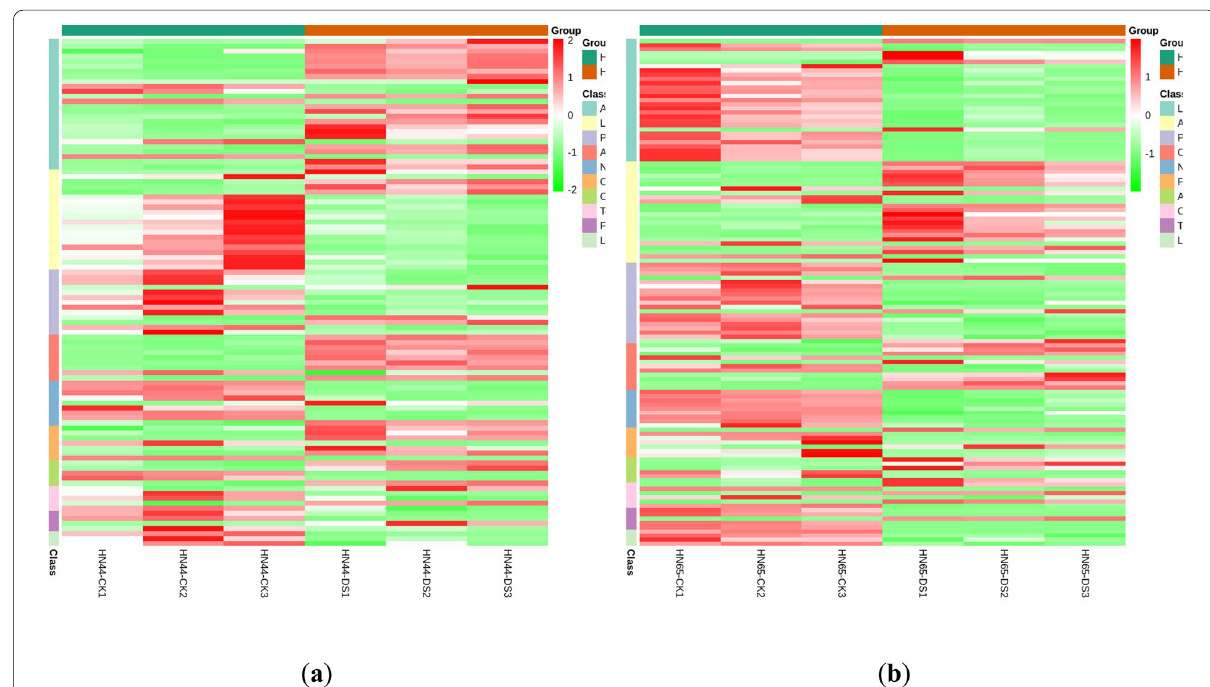
Fig. 6 Clustering heat maps of differential metabolites between the following pairs of groups: a HN44-CK vs. HN44-DS; b HN65-CK vs. HN65-DS. The abscissa represents the sample name; the ordinates represent differential metabolites and hierarchical clustering results. Red indicates high content; Green, low